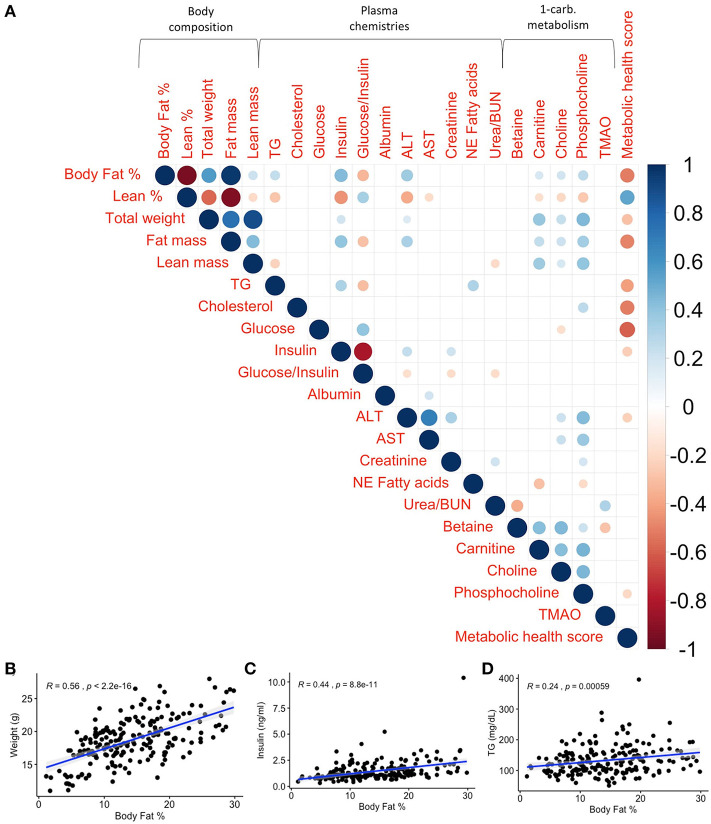
Phenotypic correlations at baseline illustrate the strength of relationships between traits without the influence of diet. Body fat % shows the strongest relationship with weight, insulin, triglycerides (TG), and metabolic health score at baseline compared to other traits. (A) Spearman's correlations of baseline phenotypes with p values adjusted using the Benjamini–Hochberg method. Only significant correlations (padj < 0.05) are shown. Scale indicates rho value. Spearman's correlations between baseline body fat % and (B) weight (R = 0.56, p <2.2 × 10−16), (C) insulin (R = 0.44, p = 8.8 × 10−11), and (D) TG (R = 0.24, p = 0.00059) show significant correlations between body fat % and obesity-associated phenotypes. R is Spearman's rho.